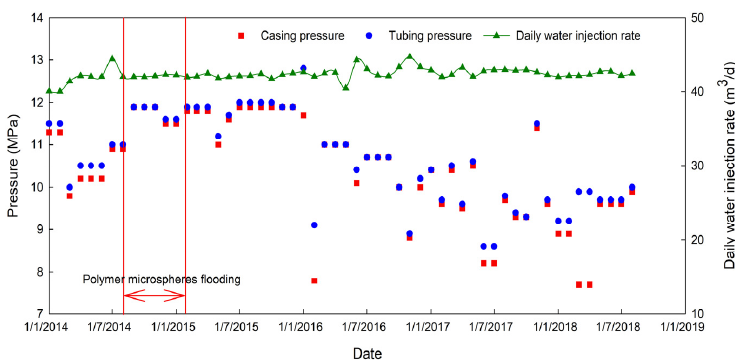
Figure 13. Daily water injection rate, casing pressure and tubing pressure.